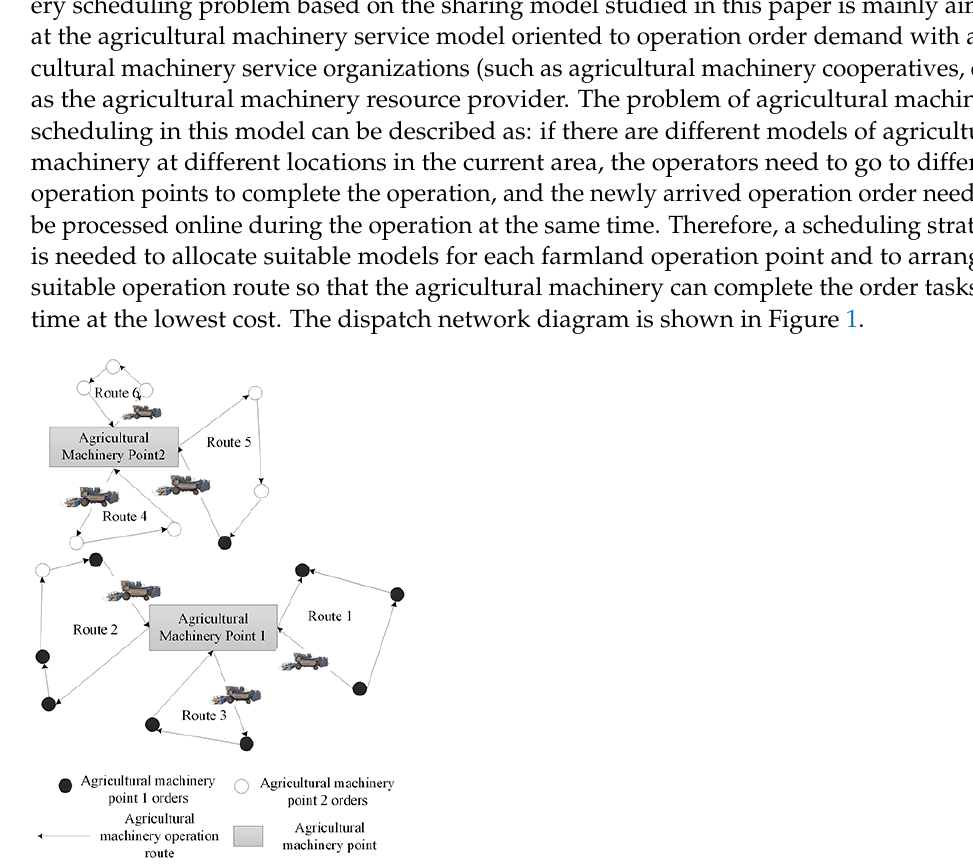
Figure 1. Network diagram of agricultural machinery scheduling in resource sharing mode.